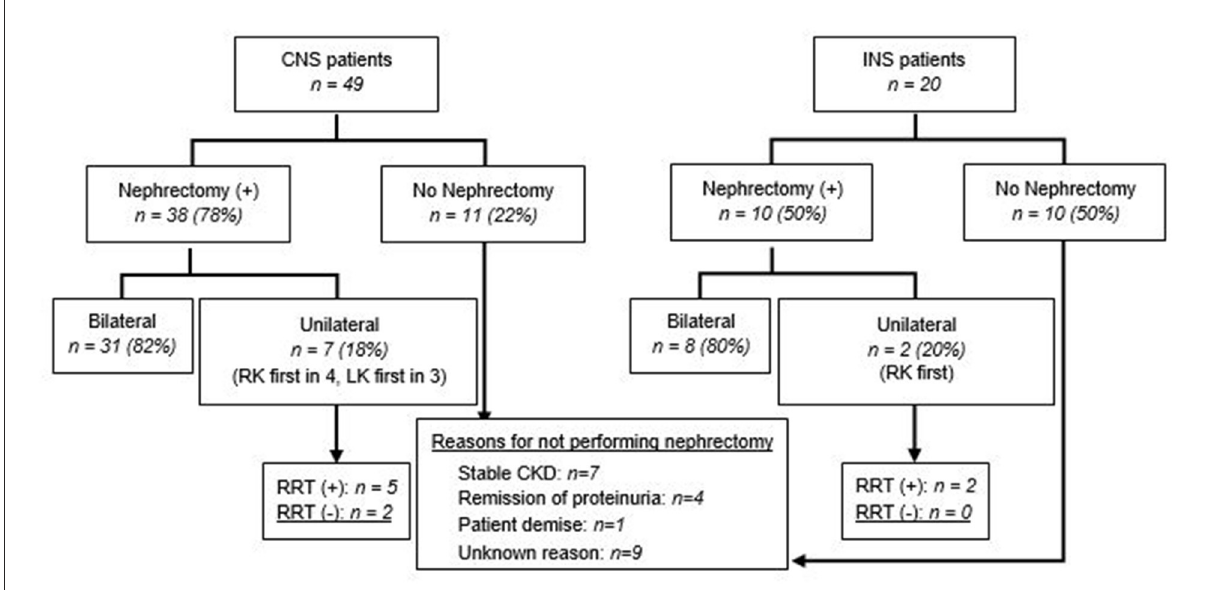
FIGURE1 Nephrectomy in patients with CNS and INS. Unilateral nephrectomy includes sequential nephrectomy. RK, right kidney; LK, left